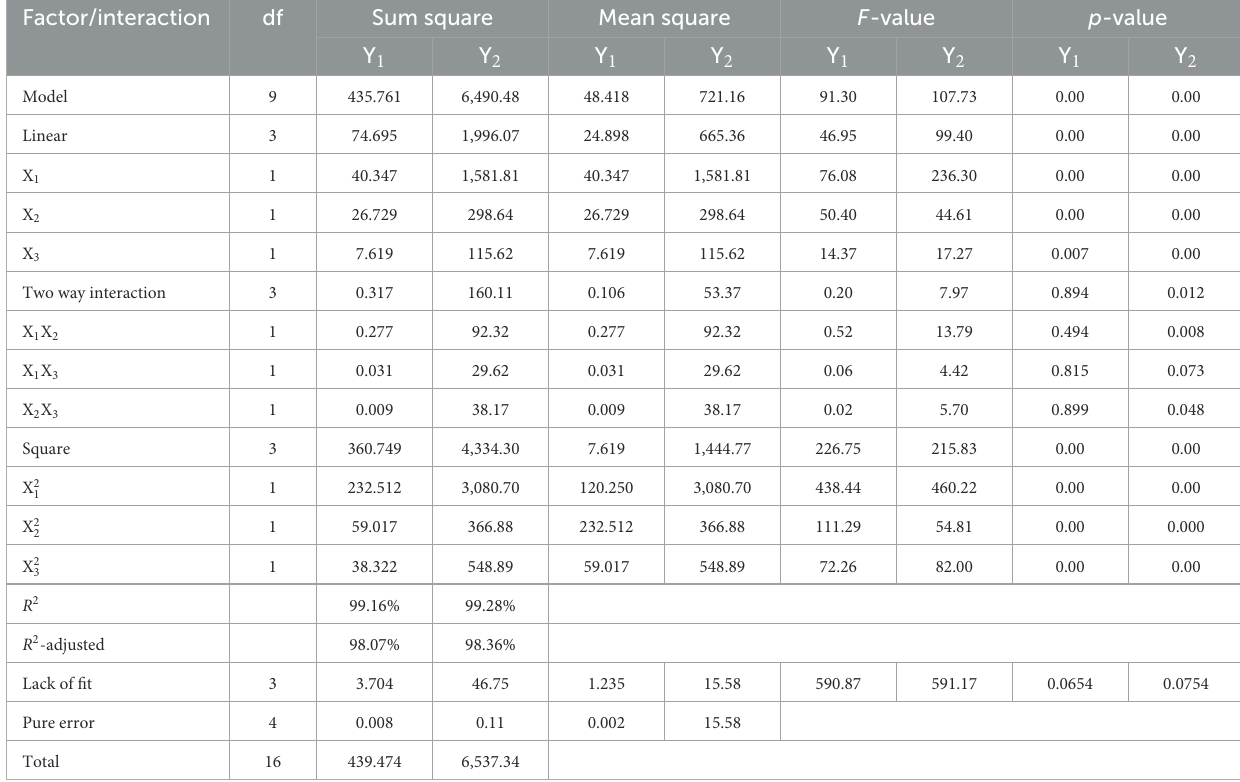
TABLE 2 Analysis of variance (ANOVA) of both responses.